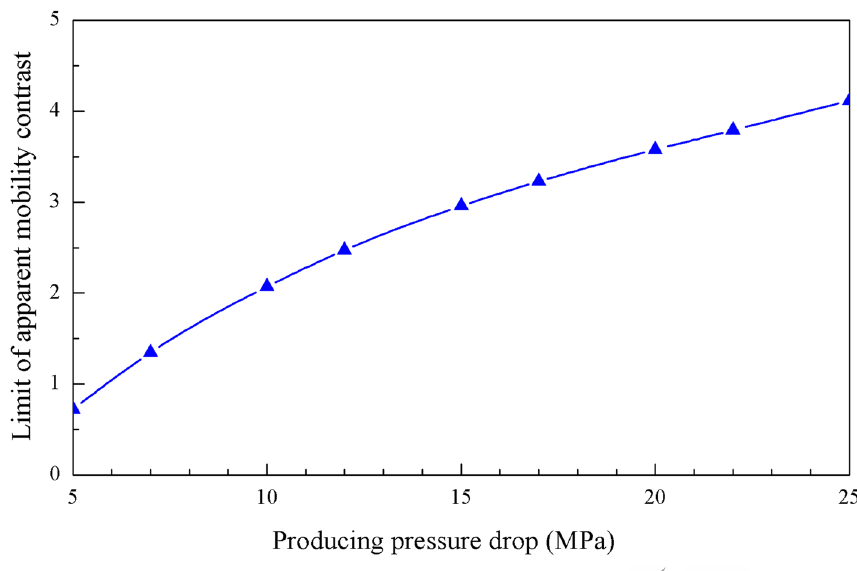
Fig. 9 Relation between limit of apparent mobility contrast and producing pressure